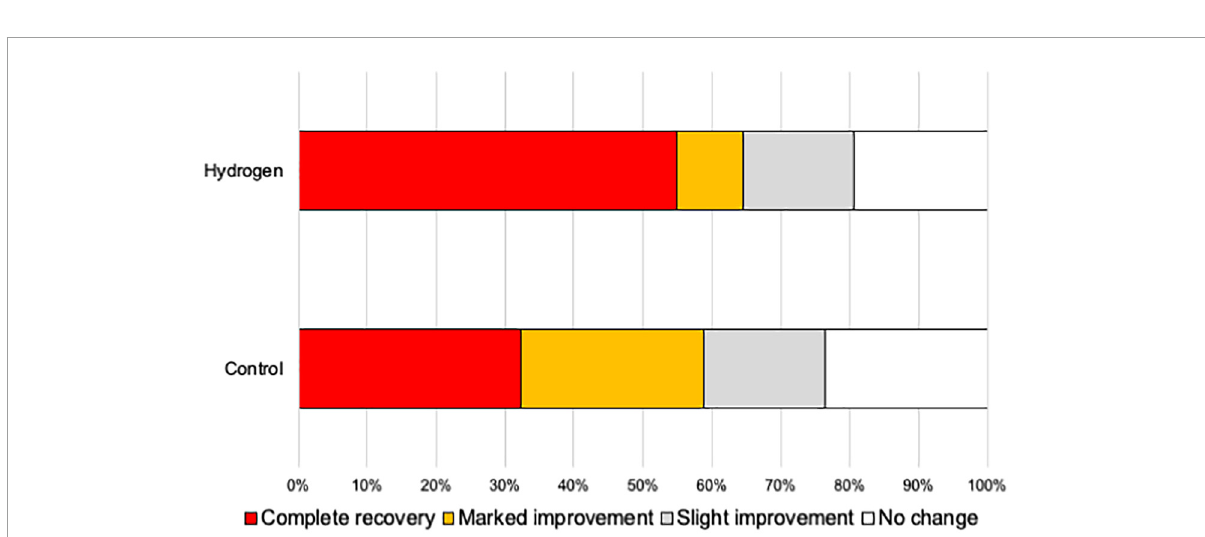
FIGURE3 Hearing outcome. The ratio of patients with a good hearing prognosis (complete recovery and marked improvement) was not significantly different between the H 2 and control